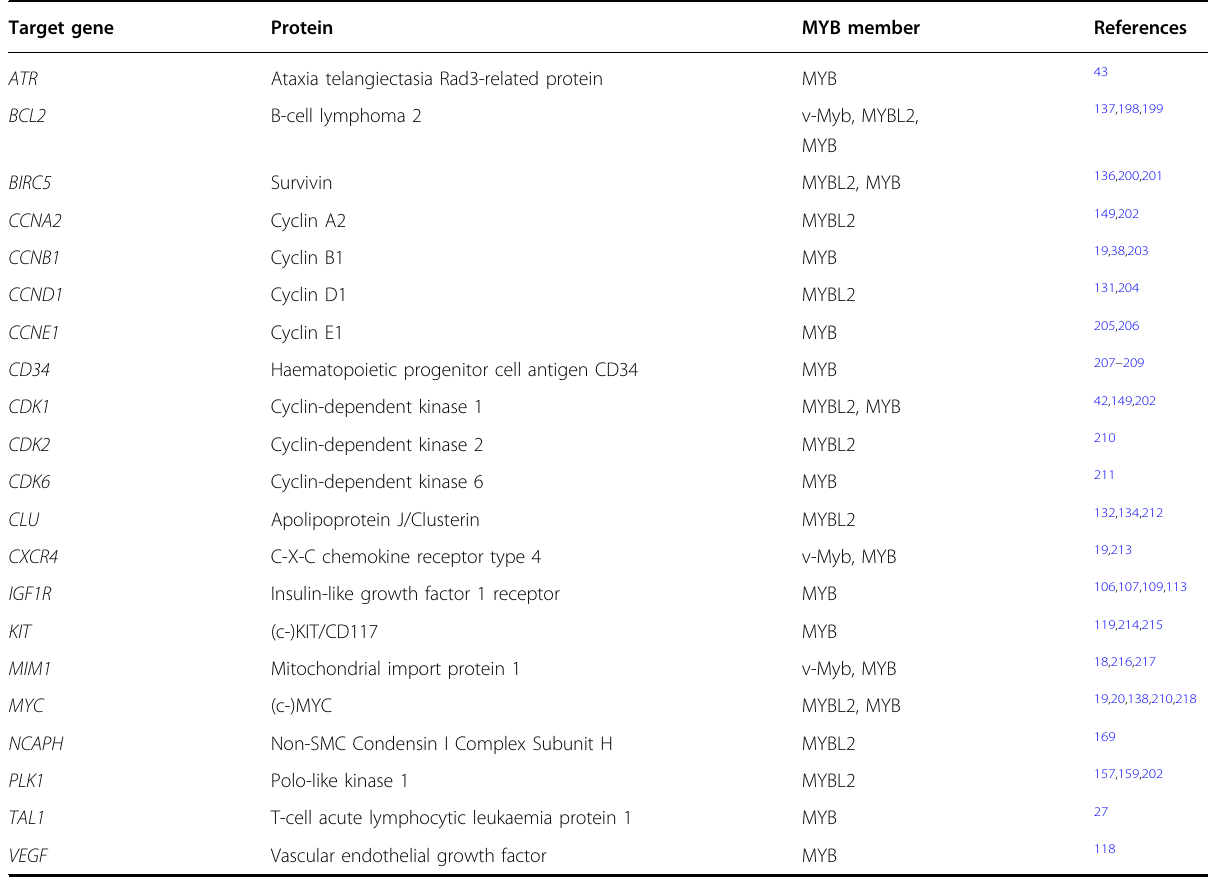
Table 1 Selected MYB target